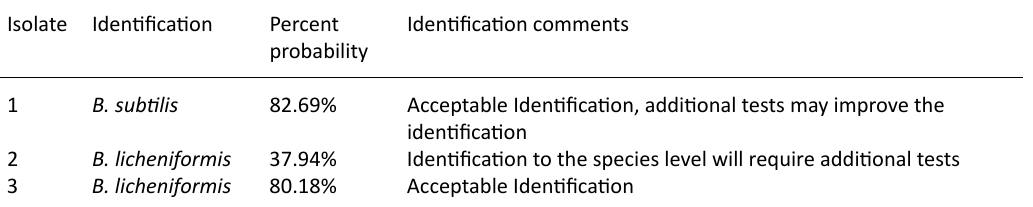
Table 1. Identification of species of the four isolates by Microgen Identification System Software (MID-60) Isolate